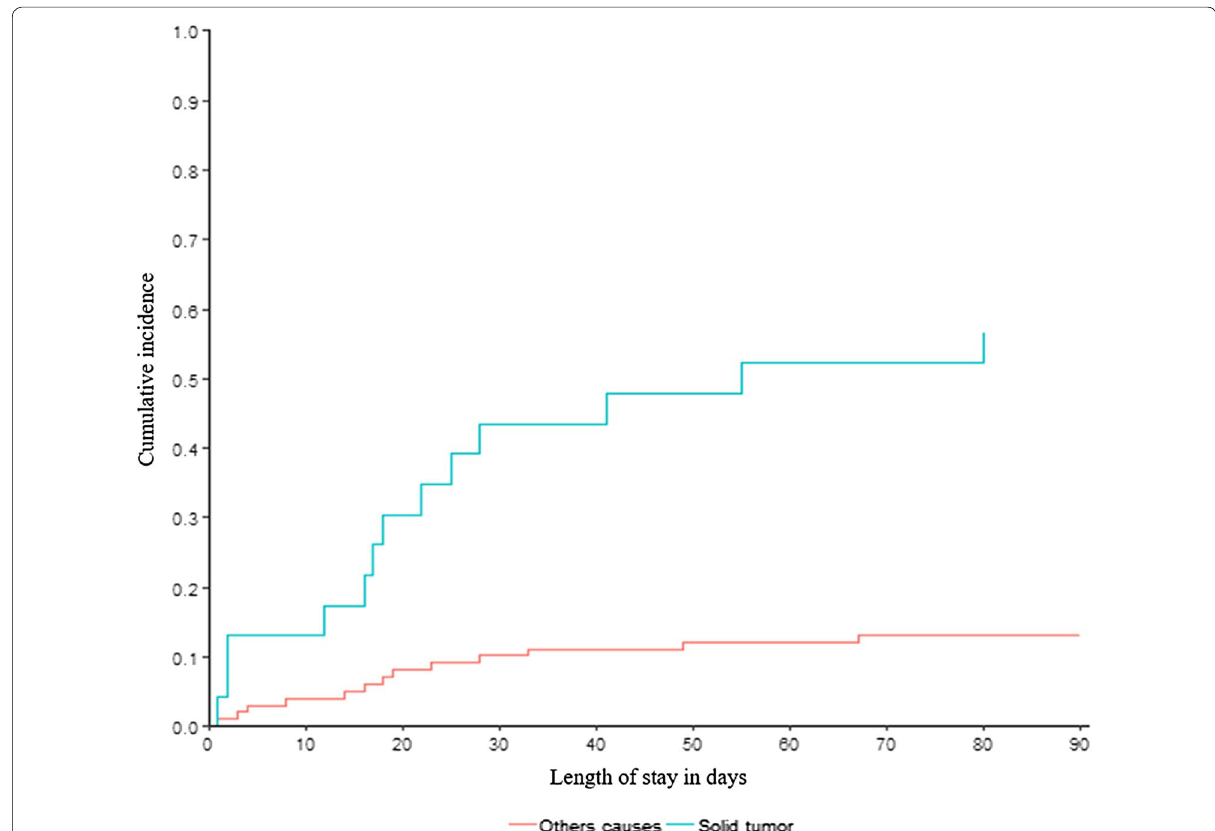
Fig. 2 Cumulative incidence of hospital mortality based on solid tumor status. Blue curve HCM from tumor etiology. Red curve HCM from other causes